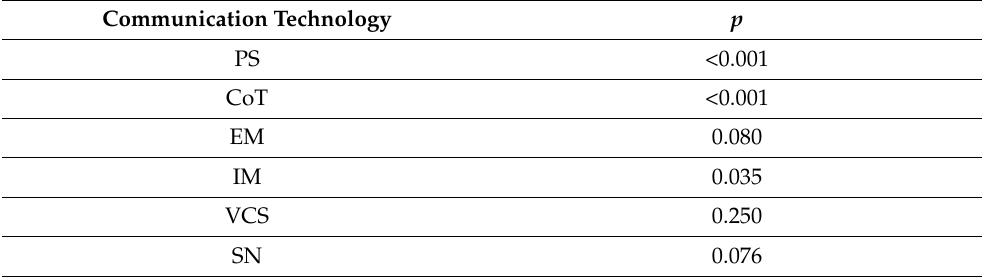
Table 18. Results of statistical inference t-test to verify the independence of students’ and teachers’